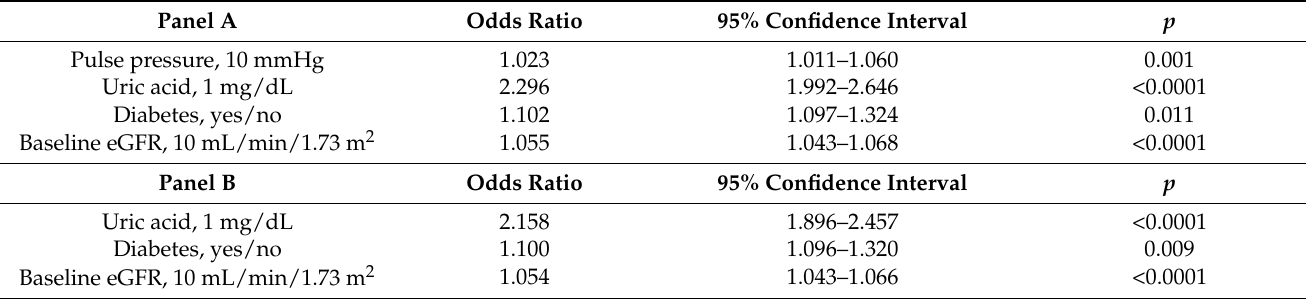
Table 6. Univariable (Panel A) and multivariable (Panel B) logistic regression analysis of the rapid decline of renal function (>5 mL/min/1.73 m 2